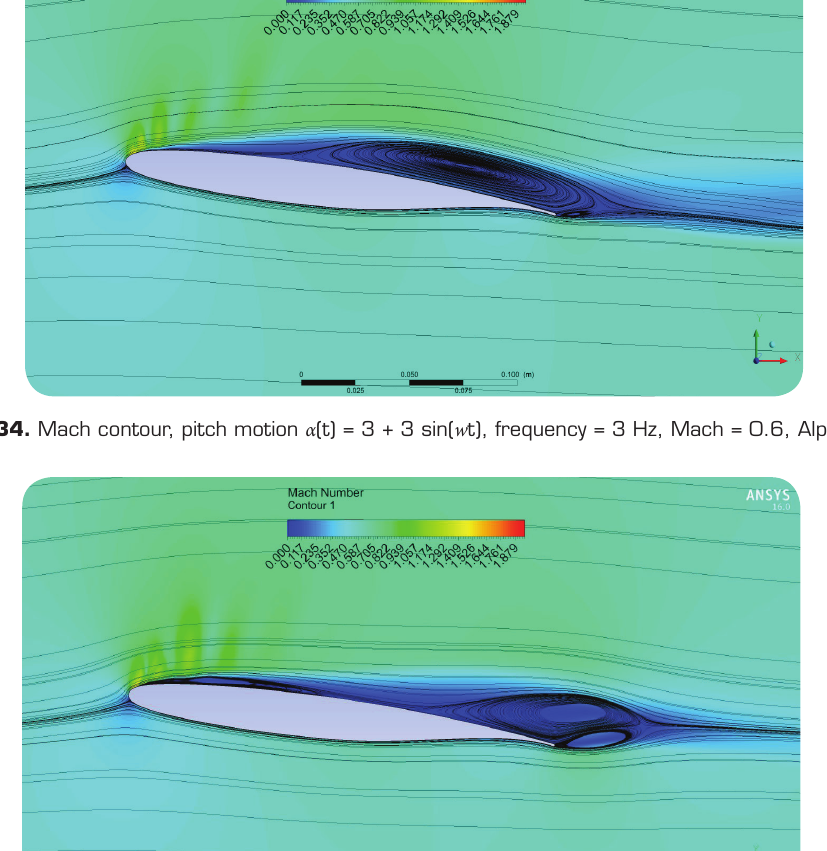
Figure 35. Mach contour, pitch motion α (t) = 3 + 3 sin( w t), frequency = 3 Hz, Mach = 0.6, Alpha =